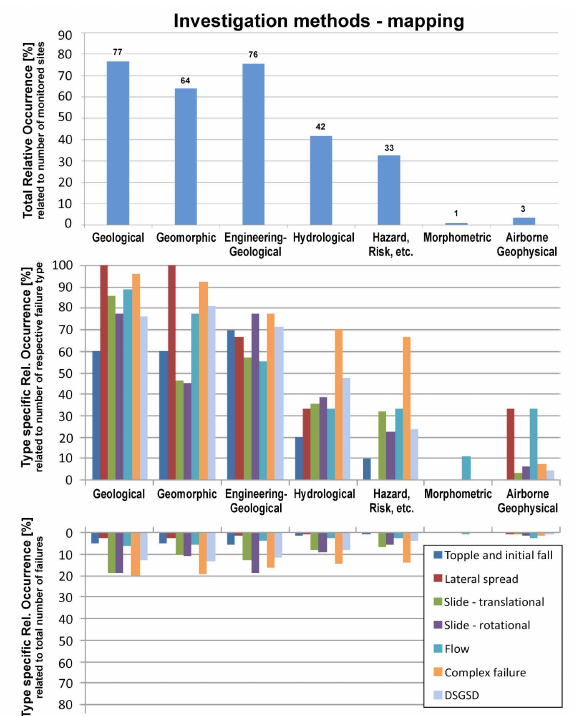
Fig. 4. Review of total relative occurrence and type-specific rela- tive occurrence of the mapping approaches applied in the monitored landslide